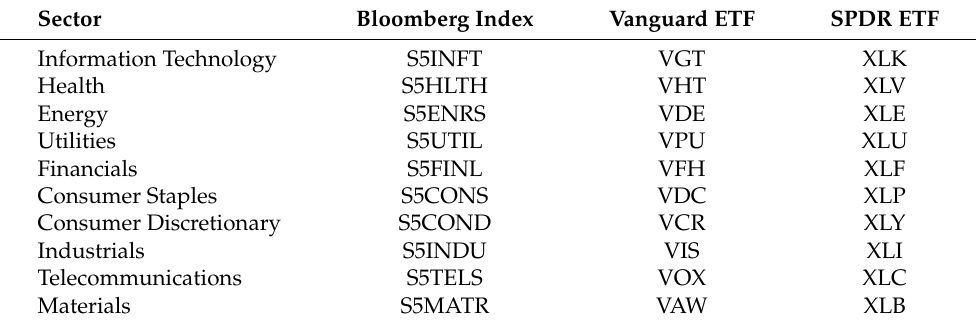
Table 1. Standard and Poor 500 sectoral indexes. The tickers for the Bloomberg level 1 indexes are reported in the second column. The last two columns indicate the corresponding ETF issued by Vanguard and